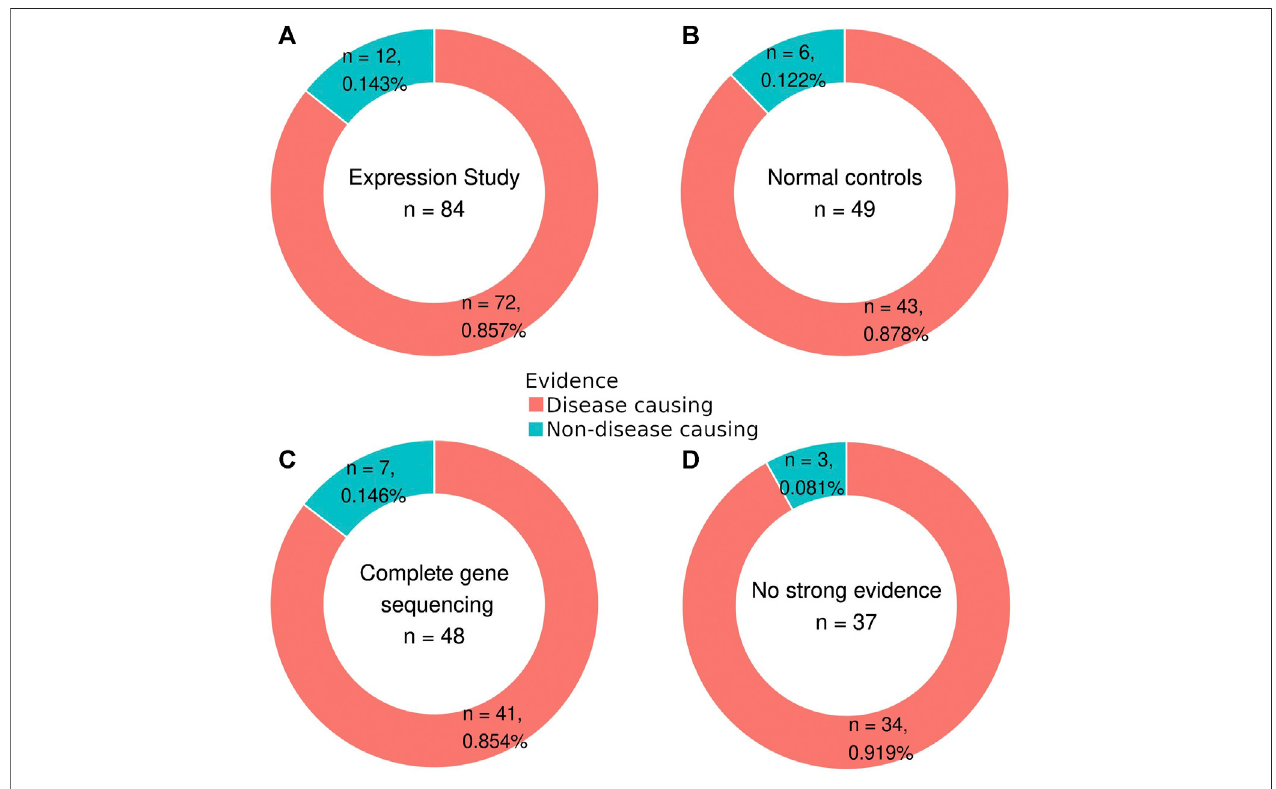
FIGURE 2 | Percentage of disease-causing and non-disease-causing variants in each evidence criterion: variants with expression study (A) , comparison with normal controls (B) , complete gene sequencing (C) , and absence of strong evidence (D) .